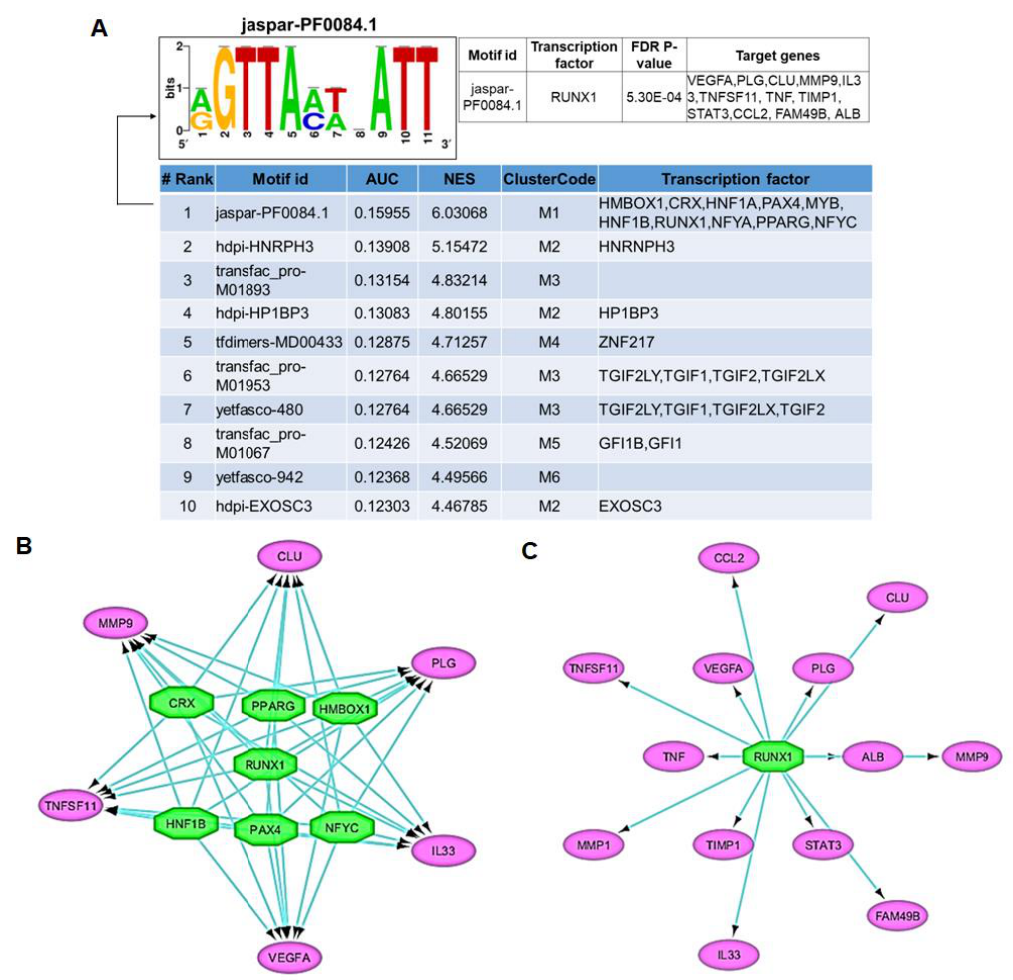
Figure 4. Transcription factor–target gene regulatory network analysis predicts RUNX1 as a major driver of IDD: Transcription factor (TF)-gene target regulatory network analysis was performed in network cluster 1 using the iRegulon plugin in Cytoscape (version: 3.7.1). ( A ) The iRegulon analysis showed the top transcription-binding motifs and their associated transcription factors found enriched in the cis-regulatory regions of the twenty genes of network cluster 1. ( B ) Regulatory network analysis represents the predicted transcriptional regulators / transcription factors (as octagonal nodes) of the target genes present in network cluster 1 (as oval nodes). To predict the transcriptional regulator using iRegulon analysis, the 24 genes from cluster 1 were used as input genes for motif and track search in the cis-regulatory control elements of genes. ( C ) The extended regulatory network analysis showed RUNX1 as the master regulatory transcription factor, which can potentially target a vast majority of the genes present in network cluster 1.